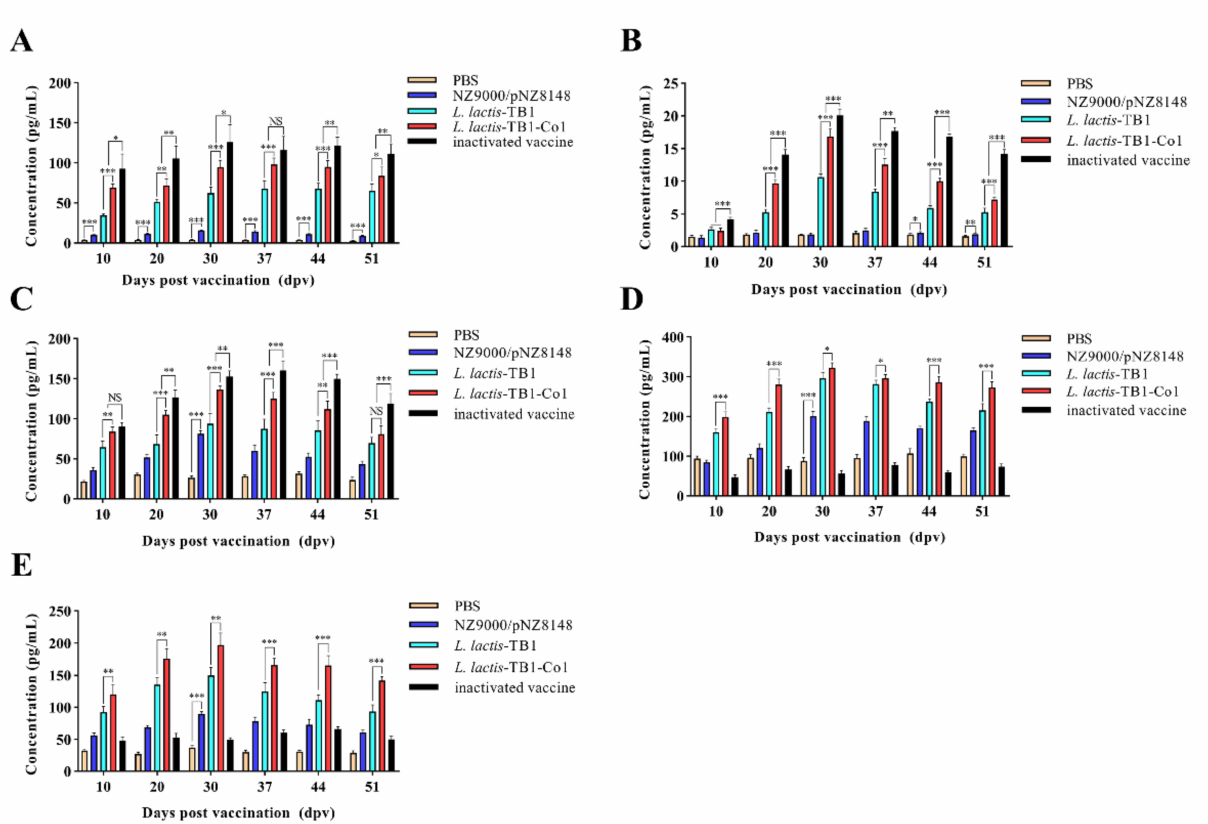
Figure 6. Detection of immune responses in mice serum samples obtained on days 10, 20, 30, 37, 44 and 51 after oral vaccination. ( A ) IL-4. ( B ) IL-5. ( C ) IL-10. ( D ) IFN- γ . ( E ) IL-2 were determined by indirect ELISA. Data are expressed as means ± SD. Analyses were performed by multiple t tests (NS = p > 0.05; * p < 0.05; ** p < 0.01; *** p <